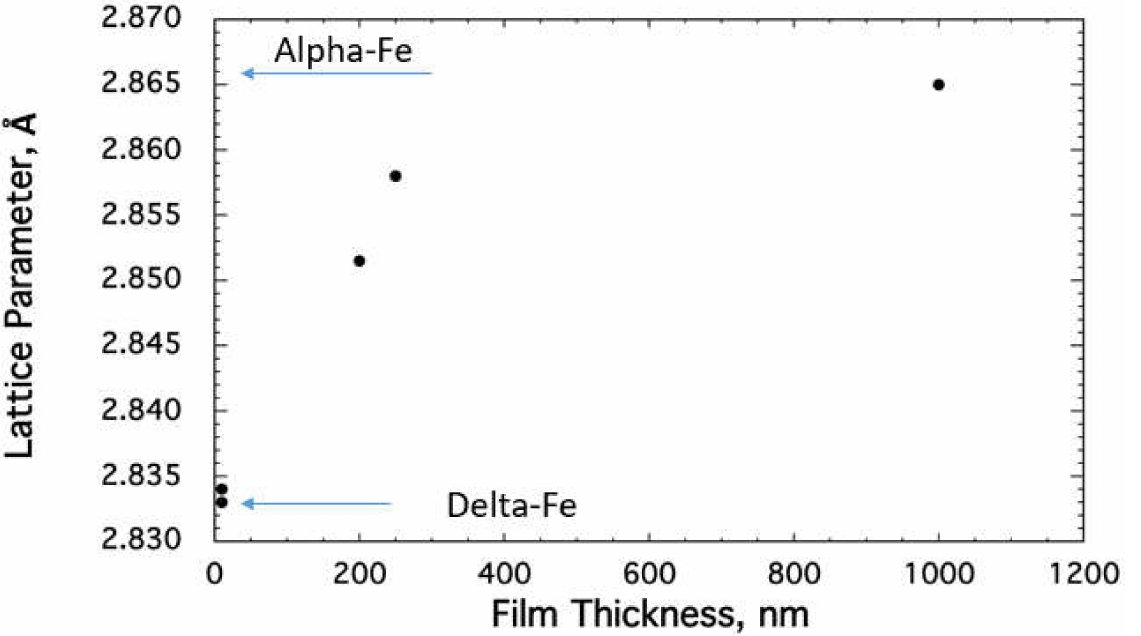
Figure 3. A plot showing the change in lattice parameter as a function of Fe film thickness on GaAs. The lattice parameter of α and δ -Fe has been indicated with an arrow.